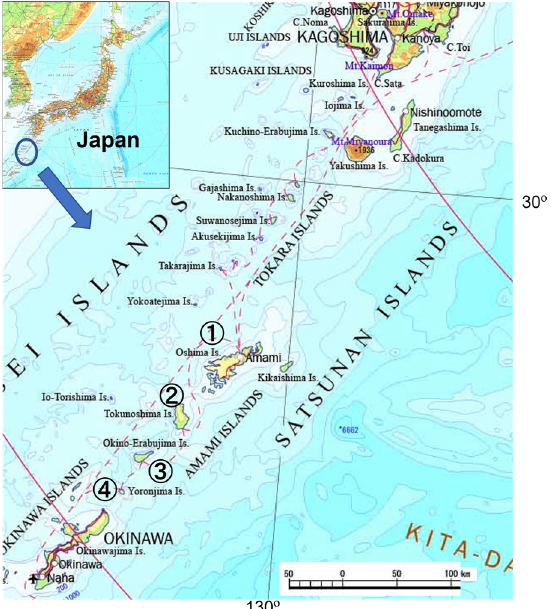
Figure 1. Map locations of the four Amami islands (1: Amami-Oshima; 2: Tokunoshima; 3: Oki- noerabu; 4: Yoron). This map is a reproduction of the Digital Map published by Geospatial Infor- mation Authority of Japan.